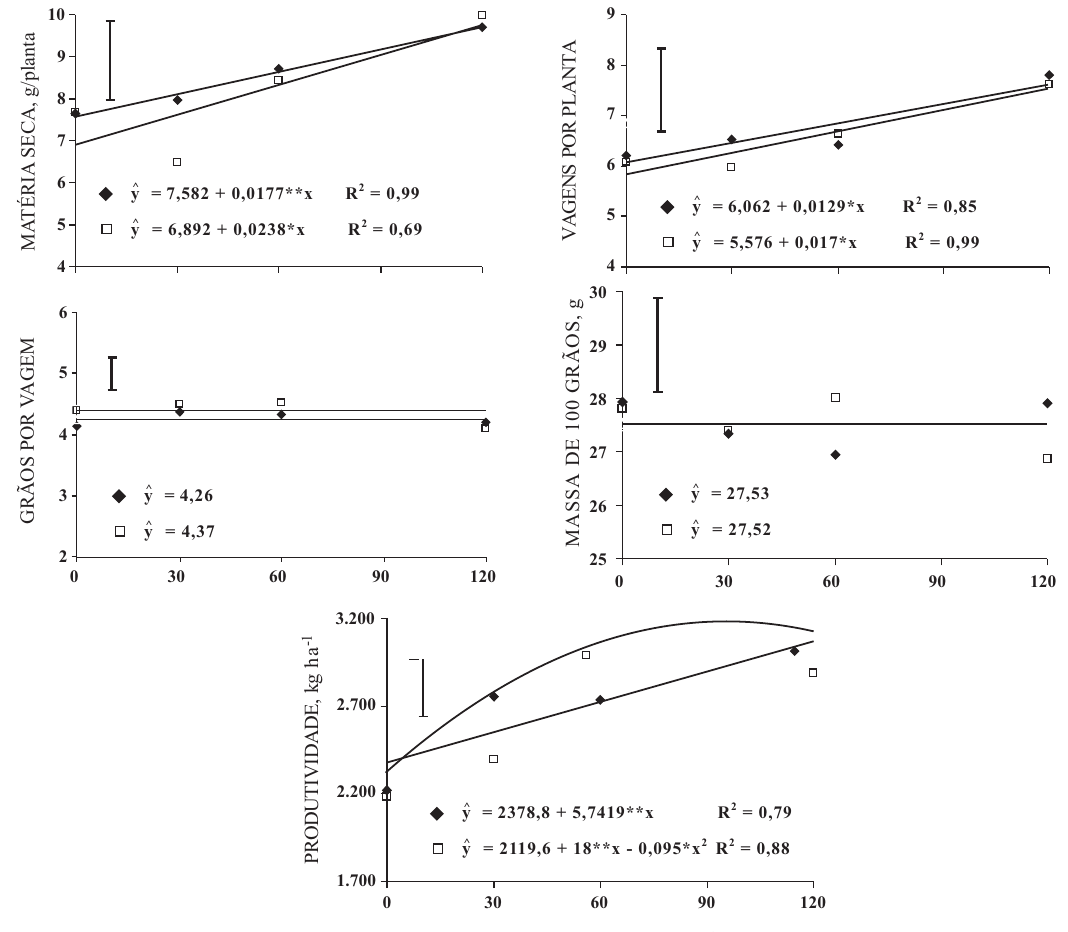
Figura 3. Massa de matéria seca da parte aérea, número de vagens por planta, número de grãos por vagem, massa de 100 grãos e produtividade de grãos do feijoeiro em função de doses de nitrogênio aplicadas em cobertura, utilizando como fonte nitrocálcio ( ) ou uréia ( ). * e **: significativos a 5 e 1 % pelo teste t, respectivamente. Barras verticais indicam o valor de DMS a 5